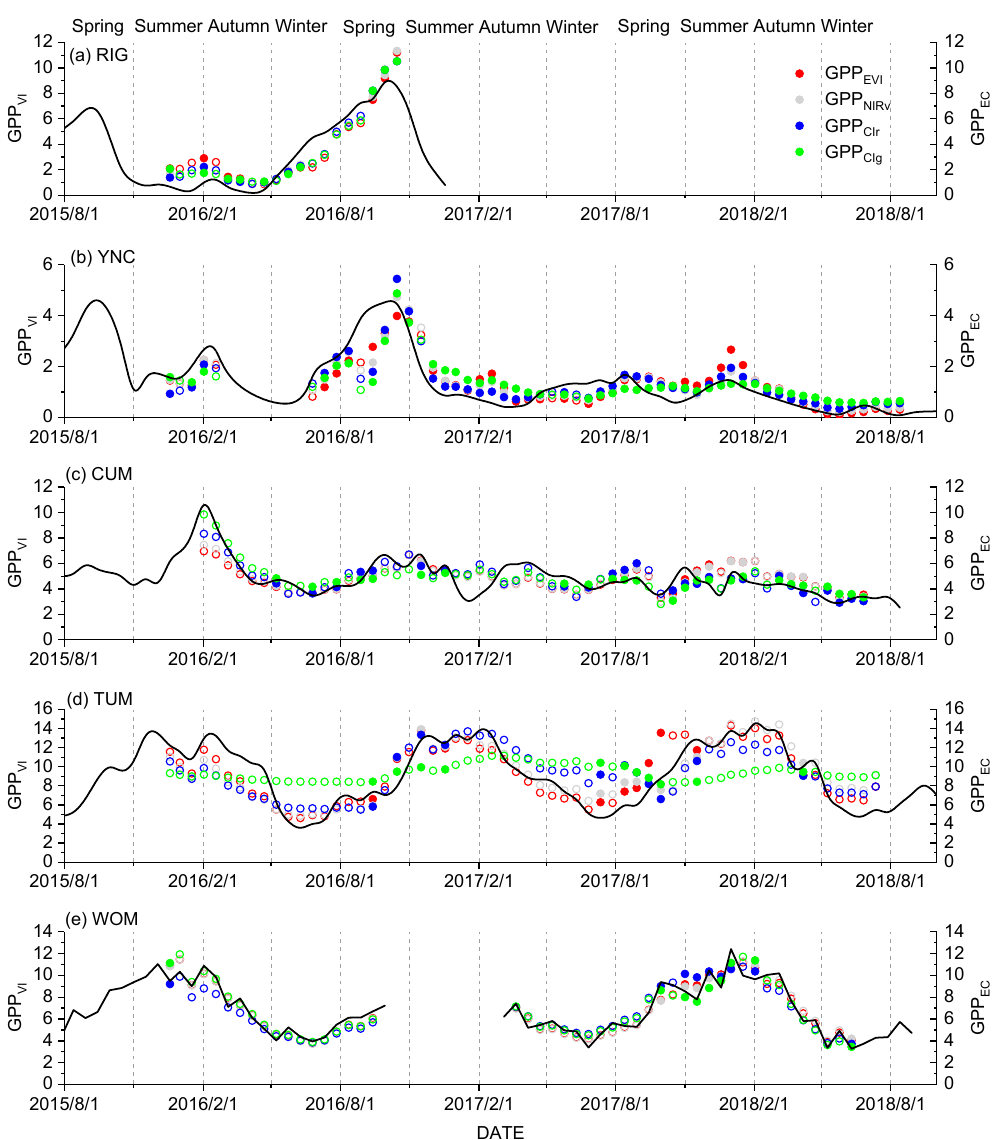
Figure 4. Time series of gross primary productivity (GPP) estimated by vegetation indices (VIs) and GPP EC for 16-day intervals at five sites ( a – e ). The solid circles are the VIs derived from satellite-based reflectance, whereas the hollow circles are the VIs derived from GPP VI , which were gap-filled using the Savitzky–Golay filter. The unit of GPP is gC ∙ m − 2 ∙ day − 1 . The Sentinel-2-based red-edge VIs such as CIr exhibited similar estimating accuracy with GPP EC under gap-filled days and non-gap-filled days (Figure 5). At WOM, the rRMSE under a cloudy sky was 0.19, which was similar to the rRMSE under a clear sky (0.17). A similar result was also observed at WOM and YNC. The seasonal change in CIr in WOM was not significant, and the GPP change was mostly accompanied by a change in PAR in (Figure 6). High cloud cover led to a low clear sky index (CSI), which influenced the image quality; thus, the gaps in the VIs in these periods needed to be filled (Figure 4). With the VIs rebuilt on a daily scale, the relationship between GPP EC and GPP CIr was different between clear and cloudy days; thus, more available data are required to investigate the relationship between the time series rebuilt in the red-edge index and GPP EC .